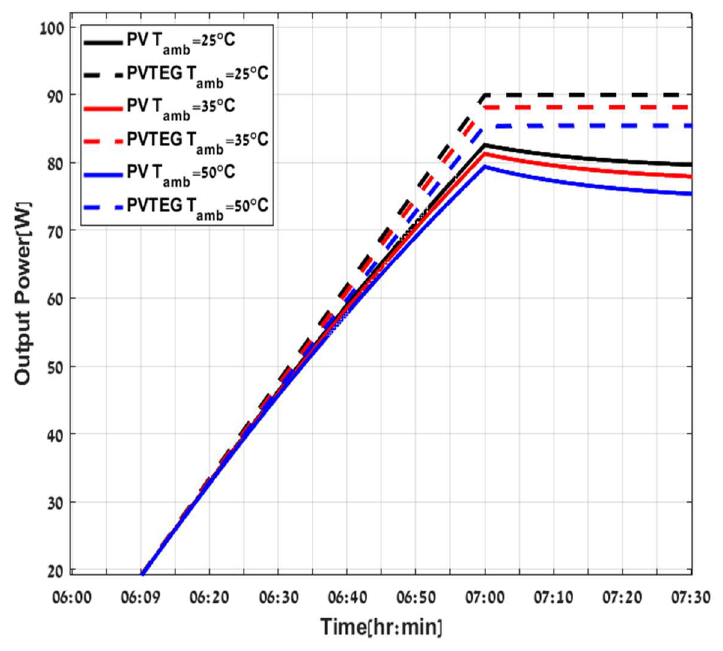
Figure 9. PV (continuous line), PVTEG (dashed line) at different T (cid:2911)(cid:2923)(cid:2912) ambient temperatures. Although there is an increase in power production in PVTEG systems, and it is more efficient than the stand-alone PV system, a large part of the energy goes through the TEG and heats the cooling water without utilization due to its low efficiency. In order to de- crease these losses, additional TEG stages were added between the cold plate and the PV module. Adding multiple stages can utilize additional efficiency from the crossing heat and increase the output power. On the other hand, each stage increases the overall thermal resistance between the PV and the cold plate. It is important to note that the high thermal resistance prevents removing the extra heat from the PV (trade-off). For the purpose of demonstrating the influence of thermal resistance, a series of simulations were extracted with constant G, h (cid:2913)(cid:2926)(cid:2879)(cid:2933) , 𝑣, T (cid:2911)(cid:2923)(cid:2912) and various TEG stages were added to examine the max- imum power generation possible. According to Figure 10, which describes the effect of installing additional TEGs on total power output and on the PV temperature, 14 stages are the upper threshold for extracting maximum energy. Adding more layers will reduce the power produced by the system. As T (cid:2911)(cid:2923)(cid:2912) = T (cid:2933) and with the increases of the overall thermal resistance between the PV and the cold plate, the heat passes through the small resistance of the top glass layer and dissipates to the environment, causing lower input power to the TEG layers. Likewise, the high thermal resistance between the cold plate and the PV prevents the cooling effect of the water from crossing the layers and influencing the solar cell, due to the increase in the PV temperature. As a result, there is a reduction in the overall power output of the system.